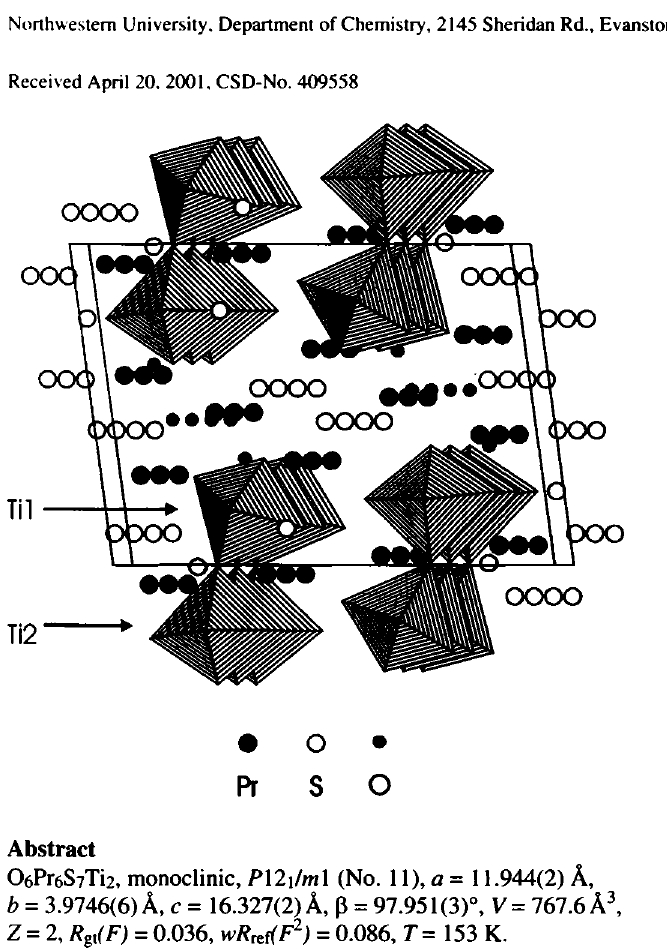
Table 1. Data collection and handling.